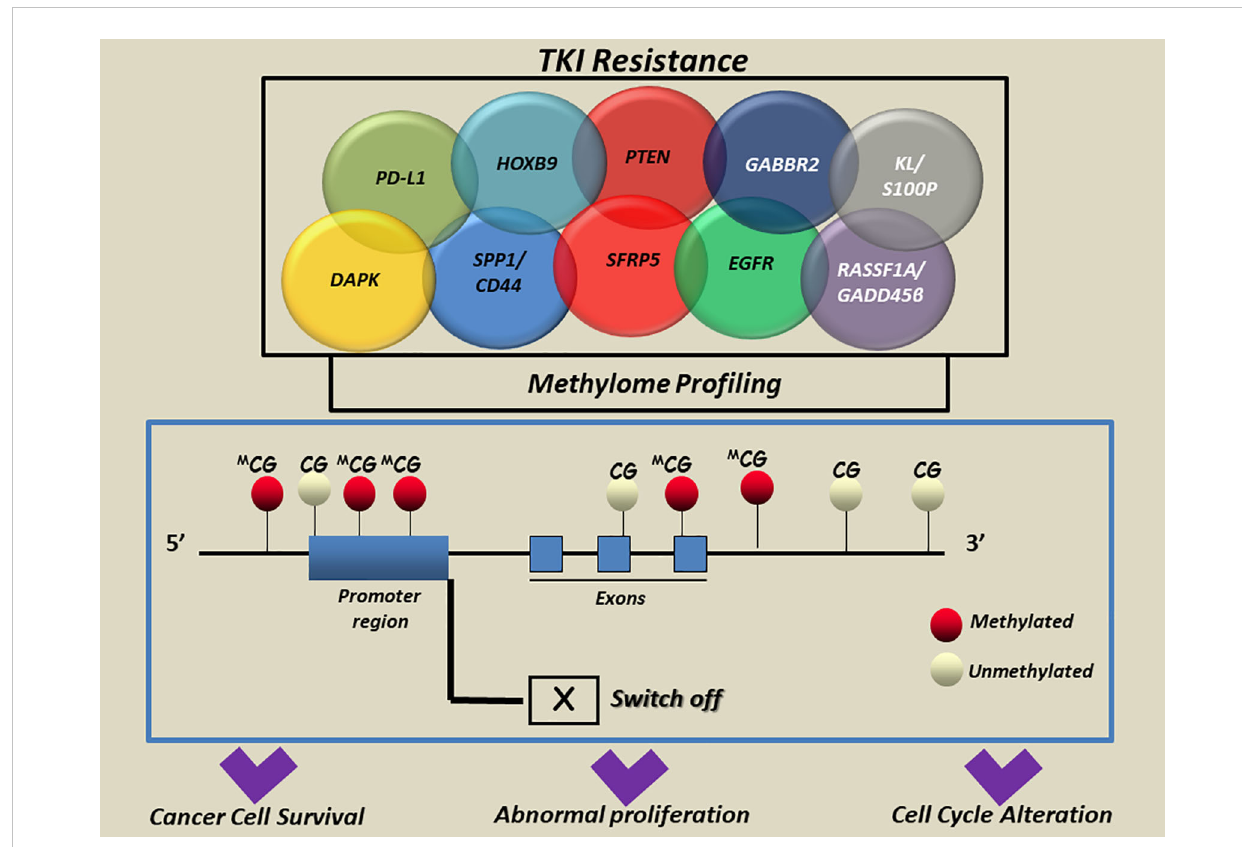
FIGURE 2 A simpli fi ed scheme of aberrant methylated genes associated with TKI resistance in NSCLC. Aberrant methylation of cytosine residues at the CpG islands in the promoter regions and/or interspersed CpGs mainly located in multiple genes was reported to modulate the transcription and induce aberrant regulation of genes implicated in cell-cycle alteration, abnormal proliferation and apoptosis escape in cancer cells. CG, cytosine guanine; DAPK, death-associated protein kinase; EGFR, Epidermal Growth Factor Receptor; GABBR2, Gamma-Aminobutyric Acid Type B Receptor Subunit 2; HOXB9, Homeobox B9; KL, Klotho; S100P, S100 Calcium Binding Protein; PD-L1, Programmed death-ligand 1; PTEN, Phosphatase And Tensin Homolog; RASSF1A, Ras association domain family 1 isoform A; GADD45 b , DNA damage-inducible 45 beta; SFRP5, Secreted Frizzled Related